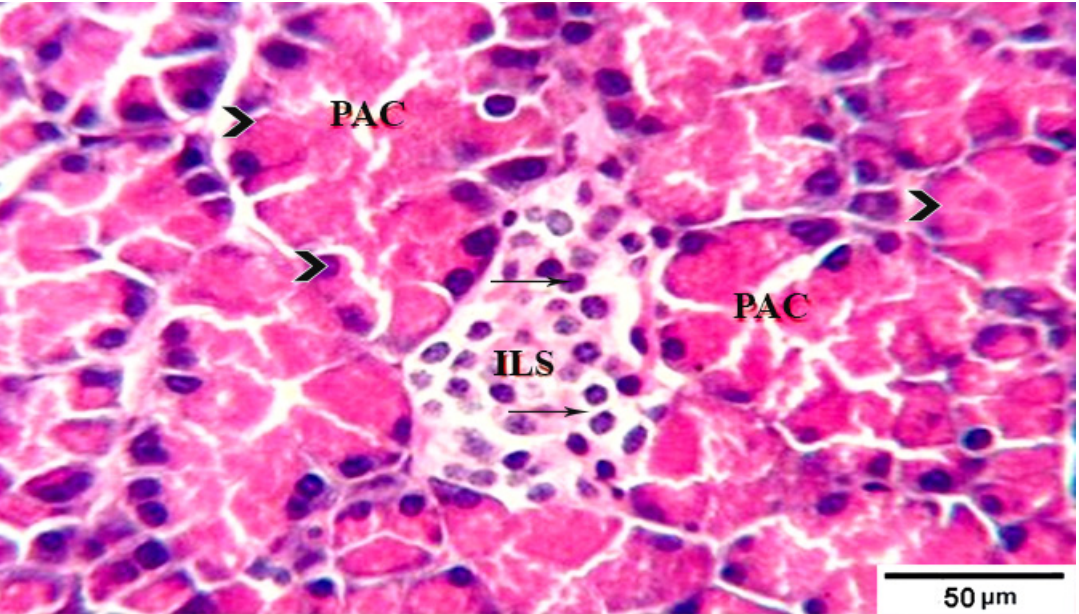
Figure 3. Photomicrograph of pancreatic tissue sections from treated group 3 rats showing well defined pale islets of Langerhans (ILs) with proliferated cell population (arrows) in between normal pyramidal acidophilic pancreatic acini (PAC) (arrowheads)H&E stain. The bar size is indicated under picture.